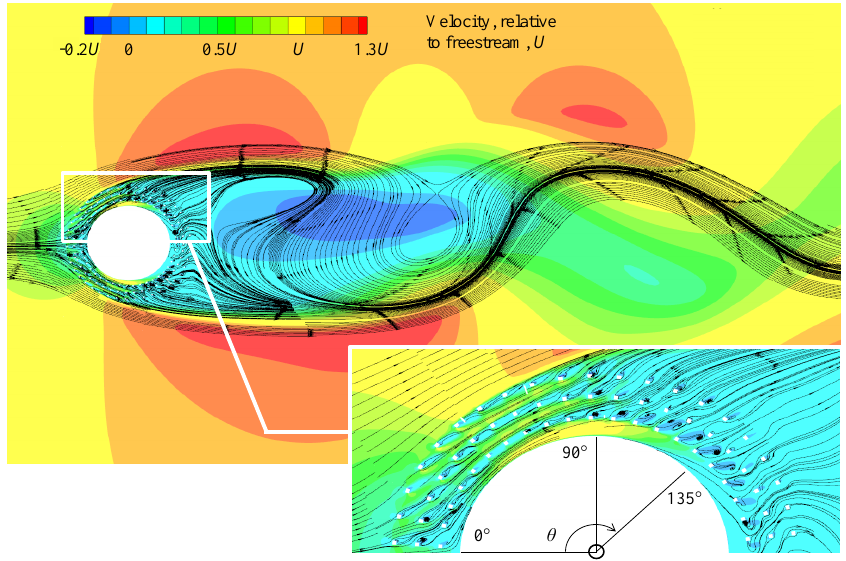
Figure 11. Preliminary CFD result of the streamlines and velocity contours of the SPCC, revealing the flow field inside the structured porous media and the near-wake. Circumferential locations, θ , are identified to assist in-text explanations. Flow is from left to